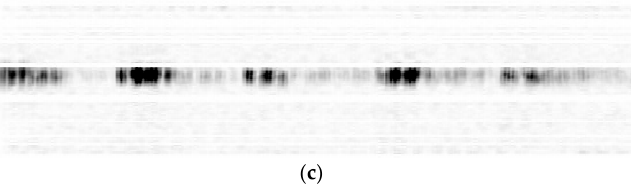
Figure 8. Images of the signals of each step: ( a ) Image of the original signals; ( b ) image of the filtered signals; and, ( c ) image of the enhanced signals.